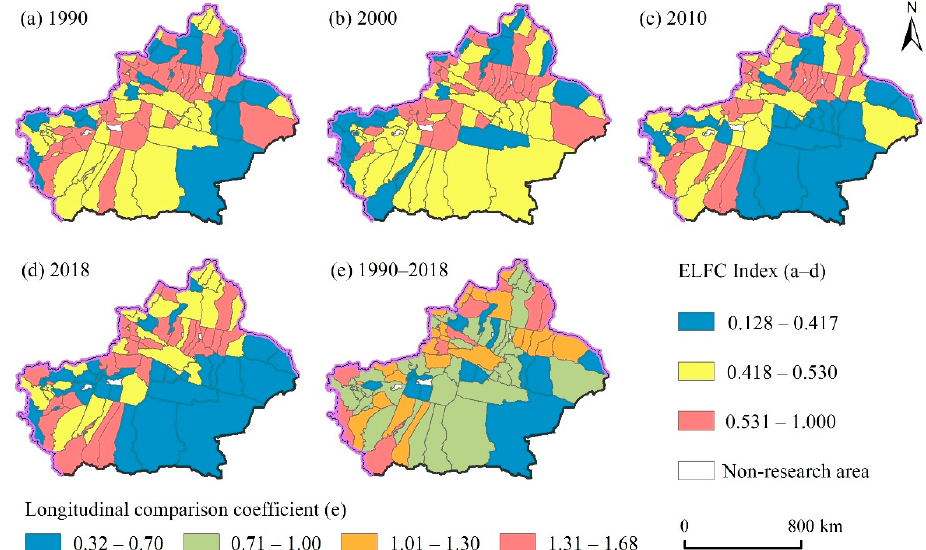
Figure 6. Temporal and spatial evolution of the ELFC at the county level in Xinjiang from 1990 to 2018: ( a ) ELFC in 1990; ( b ) ELFC in 2000; ( c ) ELFC in 2010; ( d ) ELFC in 2018; and ( e ) Changes in ELFC in 2018 compared to 1990.